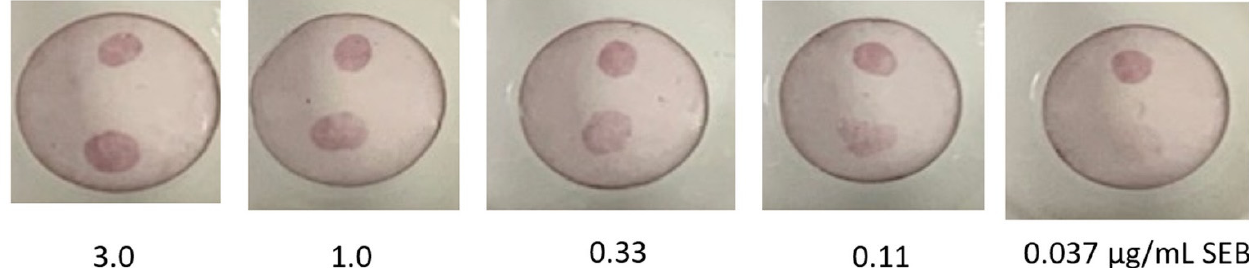
Figure 1. Vertical flow assay for the detection of SEB using A3H2-hop coated AuNPs. Each Miriad test cartridge was spotted with ACVE-ACVE near the bottom and goat anti-VHH near the top, as a control. After each cartridge was challenged with 100 µL of SEB at the indicated concentration, 100 µL of A3H2-hop AuNP was applied to generate the colored spot.